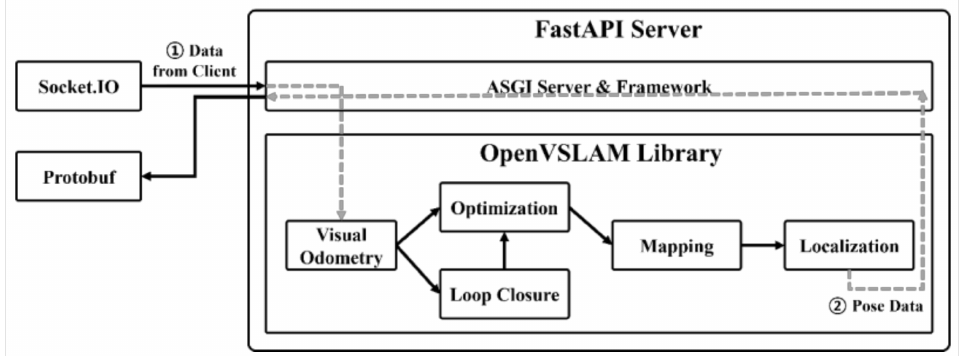
Figure 6. SLAM procedure by FastAPI-based mapping server.